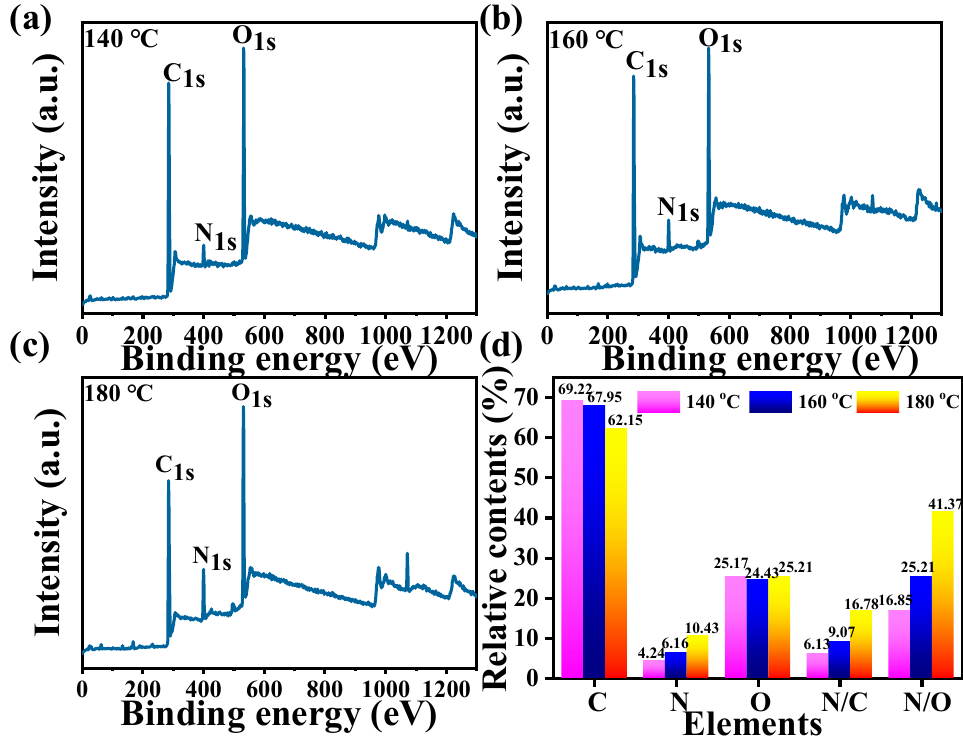
Figure 3. XPS spectra of mussels-derived CDs prepared at ( a ) 140 °C, ( b ) 160 °C, and ( c ) 180 °C, respectively; ( d ) relative contents of C, N, and O in mussels-derived CDs formed at different reaction temperatures.